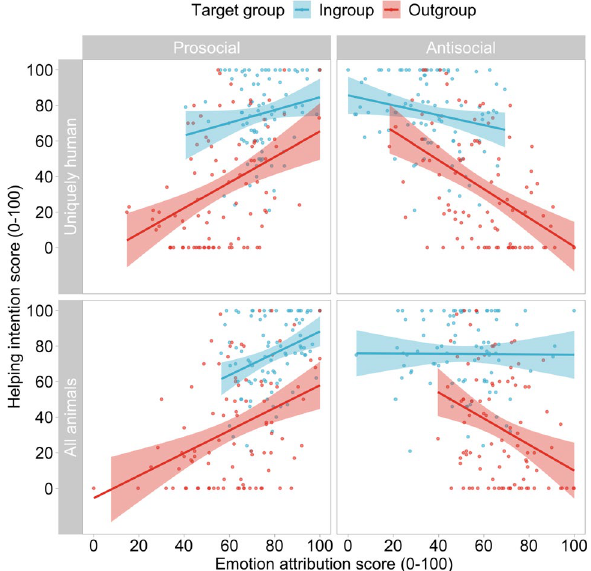
Figure 2. Contrary to predictions of infrahumanization theory, the extent to which participants attributed prosocial emotions positively predicted the extent to which they were willing to help ingroup and outgroup members, but the extent to which participants attributed antisocial emotions negatively predicted the extent to which they were willing to help outgroup (but not ingroup) members, regardless of emotion